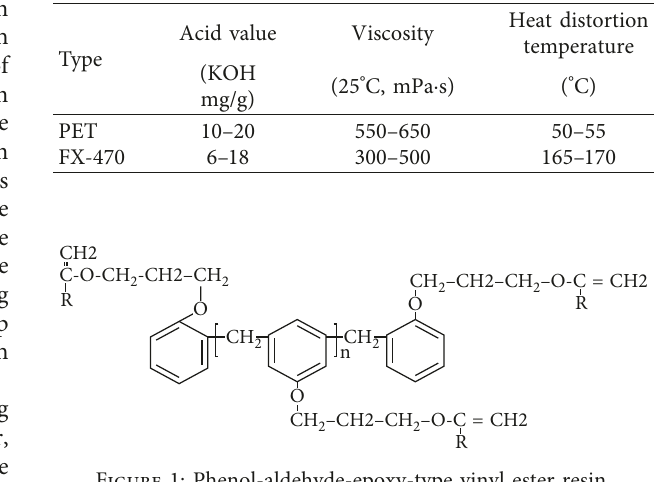
Table 1: Liquid index of resin.